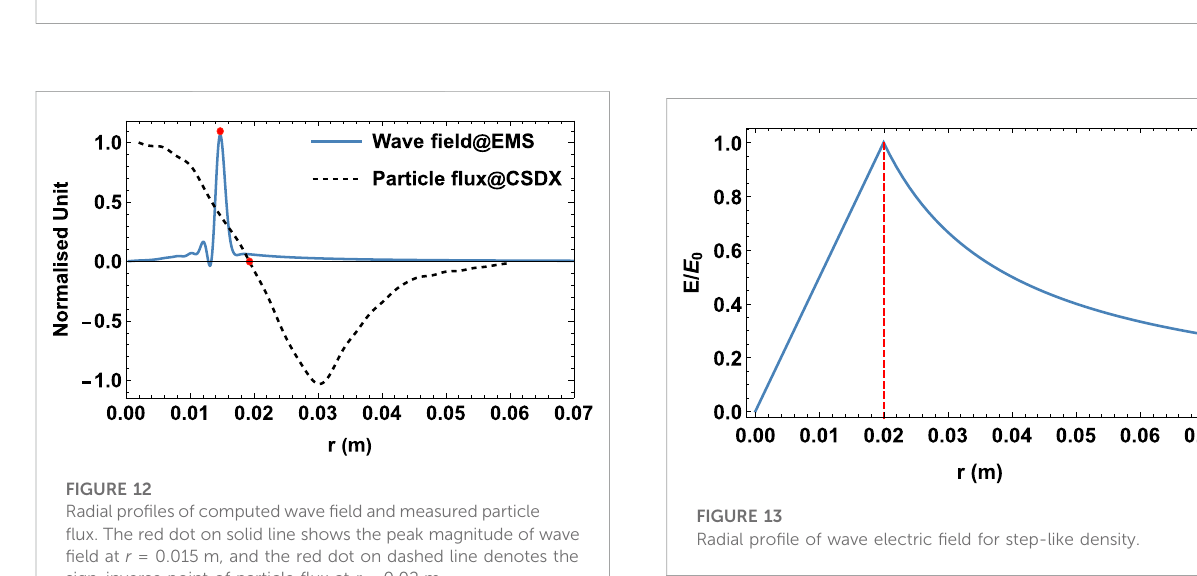
FIGURE 11 Power absorption density for typical four magnetic fi eld strengths. White area shows magnitude higher than the range of colour bar.